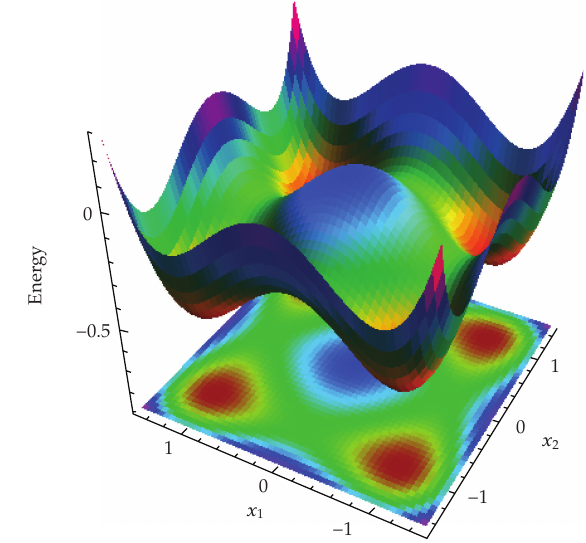
Figure 5: Energy landscape of the same two-dimensional system as in Figure